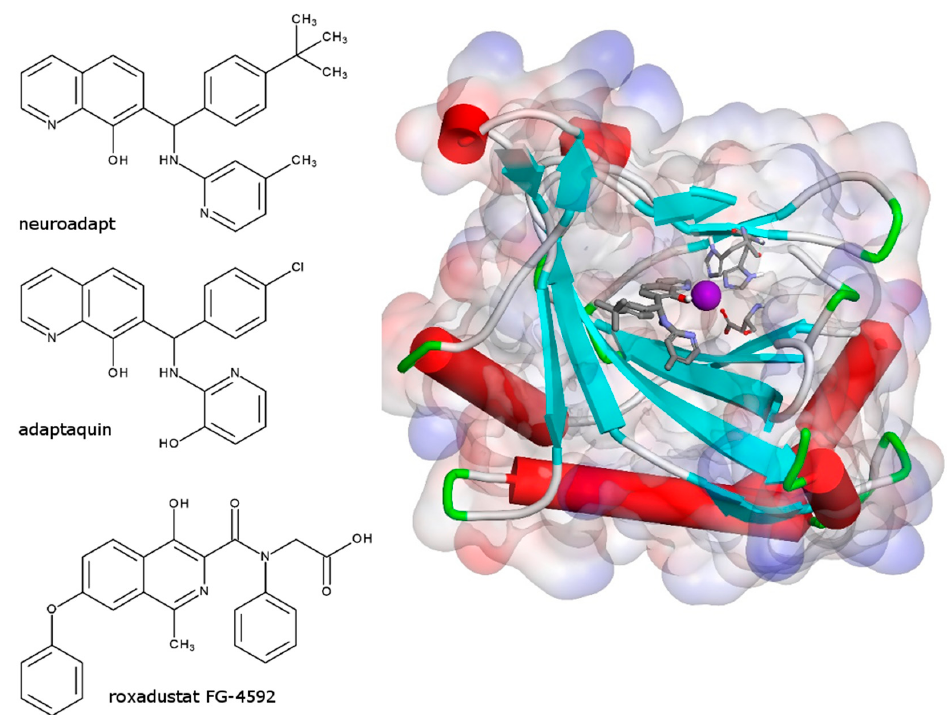
Figure 1. Chemical structures of HIF PHD pan-inhibitors, e.g., neuradapt, adaptaquin and roxadustat; and neuradapt docking into the PHD2 crystal structure (2G19.pdb). The active site iron shown in deep purple is coordinated by two histidine and one asparatate residues; the neuradapt oxyquinoline ring provides two ligands to the iron. Docking performed with Discovery Studio 3.0.